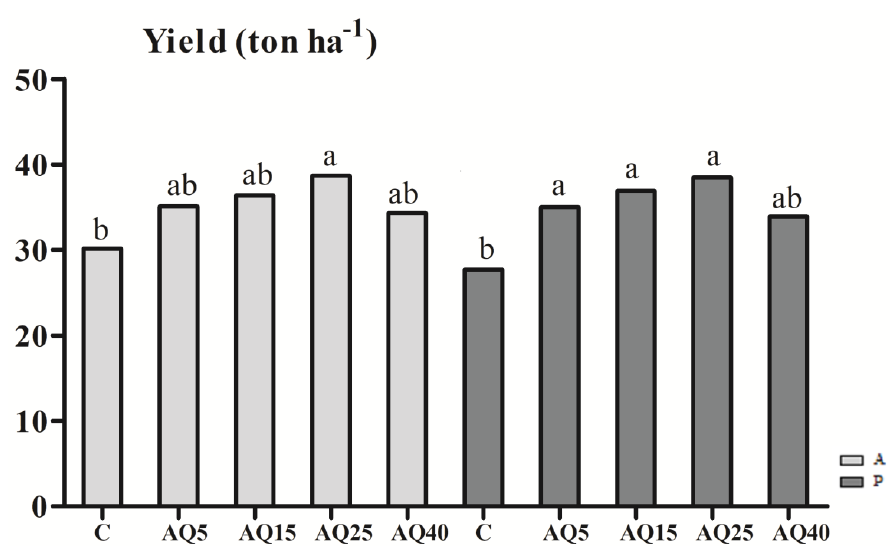
Figure 4. Yield of Perfecta and Alvar á onion cultivars submitted to foliar applications of A. quadri- cellulare microalgae biomass suspensions at different concentrations. Treatments: 0 g L − 1 (control); 0.05 g L − 1 (AQ 5); 0.15 g L − 1 (AQ 15); 0.25 g L − 1 (AQ 25); 0.4 g L − 1 (AQ 40). Means followed by the same letter in the same column do not differ statistically ( p < 0.05) according to Tukey’s test ( n =